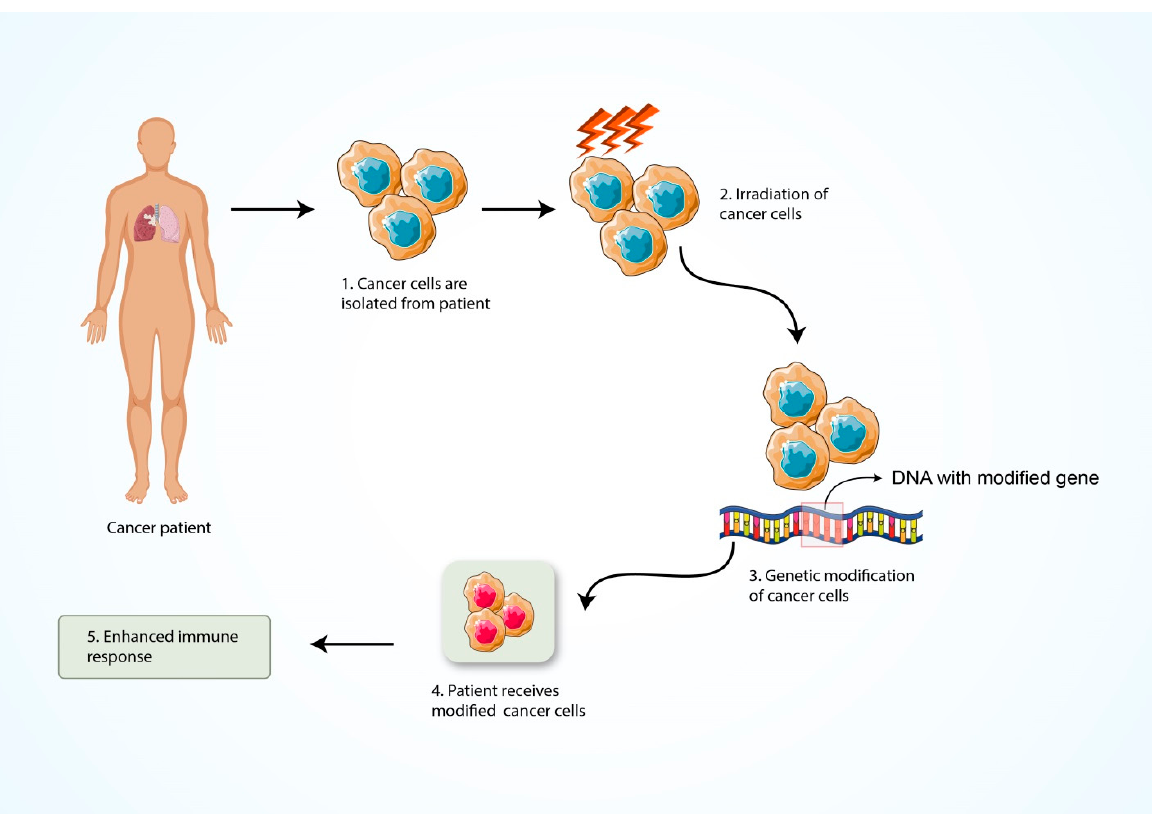
Figure 3. The steps for the formation of cancer vaccine. A surface protein found on the surface of cancer cells and vaccine developed depending on the structure of that protein. Here, the DNA with modified gene will be inserted into the cancer cells by using irradiation of the cancer cells.